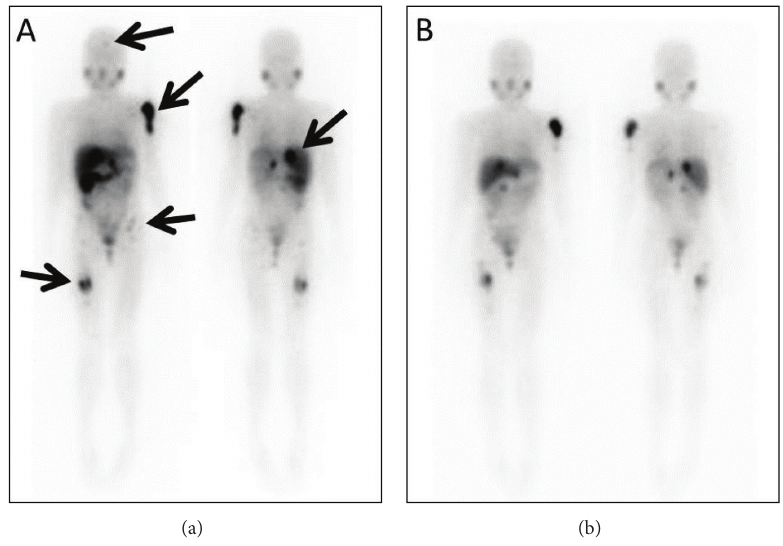
Figure 1: A 13-year-old female with relapsed neuroblastoma. She received the first I-131 MIBG therapy at a dose of 5.0 mCi/kg. Multiple accumulations are seen in a right retroperitoneal recurrence and multiple bone metastases ((a), arrows). The second I-131 MIBG therapy at a dose of 4.9 mCi/kg was performed 4 months after the first therapy. A scintigram after the second therapy shows a disappearance of left femoral uptake and decreasing uptakes in other lesions especially in a right retroperitoneum recurrence and a left humeral bone metastasis (b). Though the objective response at the first therapy was stable by the response evaluation criteria in solid tumors, she became free of pain in the lower extremity after the first therapy. Unfortunately, she died of progressive disease 14 months after the first I-131 MIBG